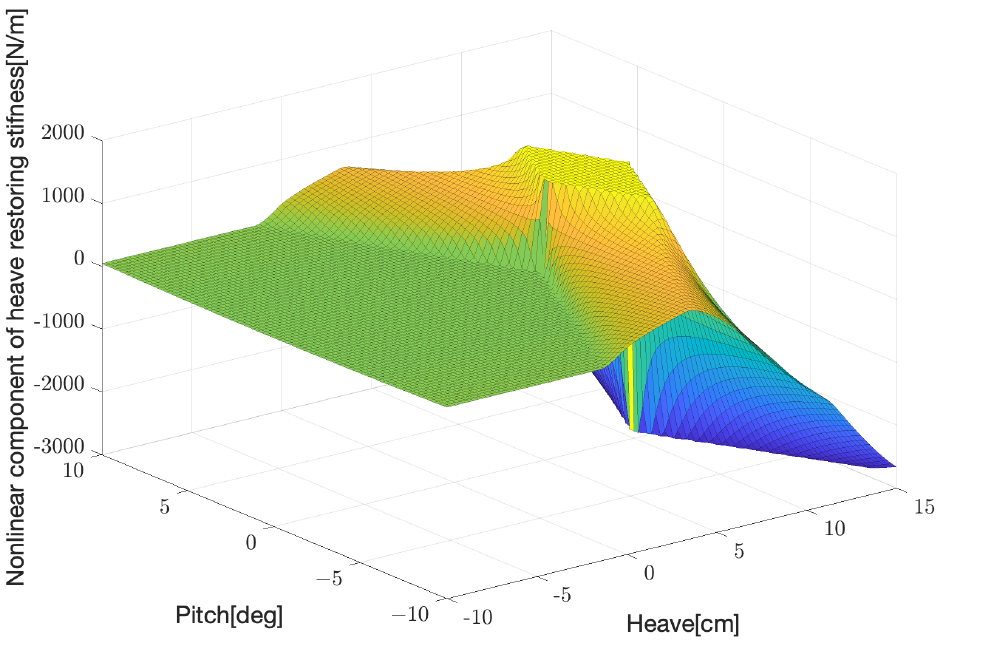
Figure 21. Nonlinear component of the restoring stiffness of